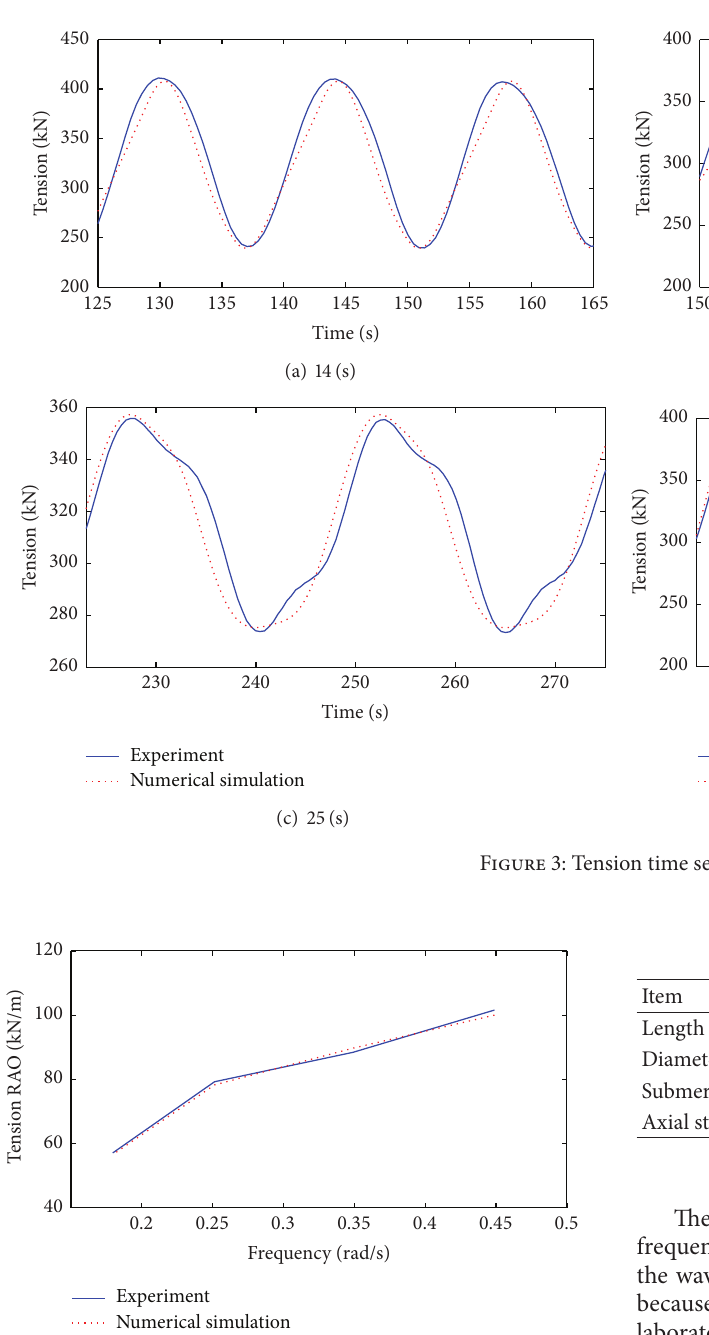
Figure 4: RAO of the mooring line tension.